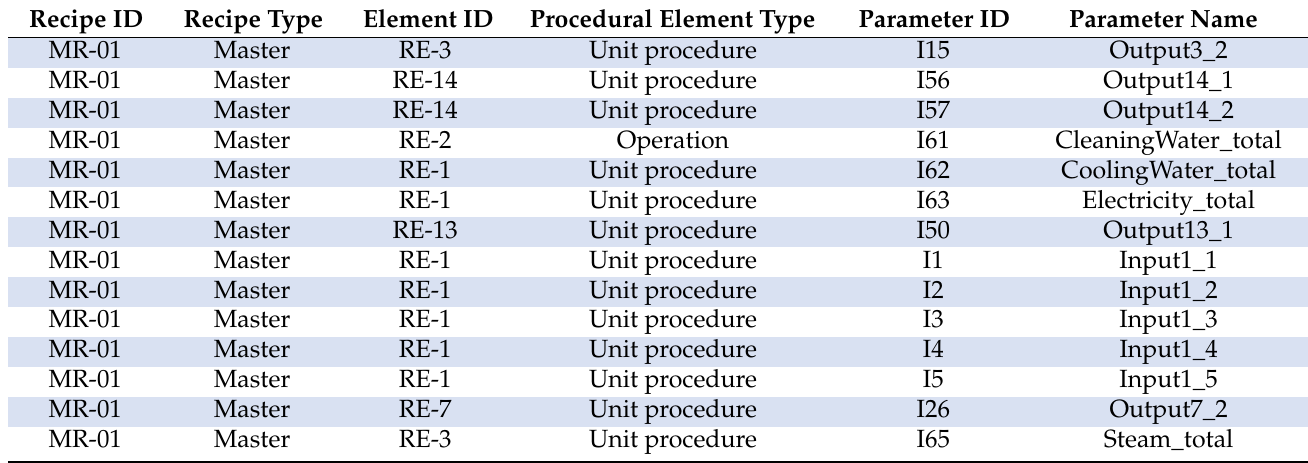
Table 5. The formula for the master recipe of acrylic fiber A production process 1/2.